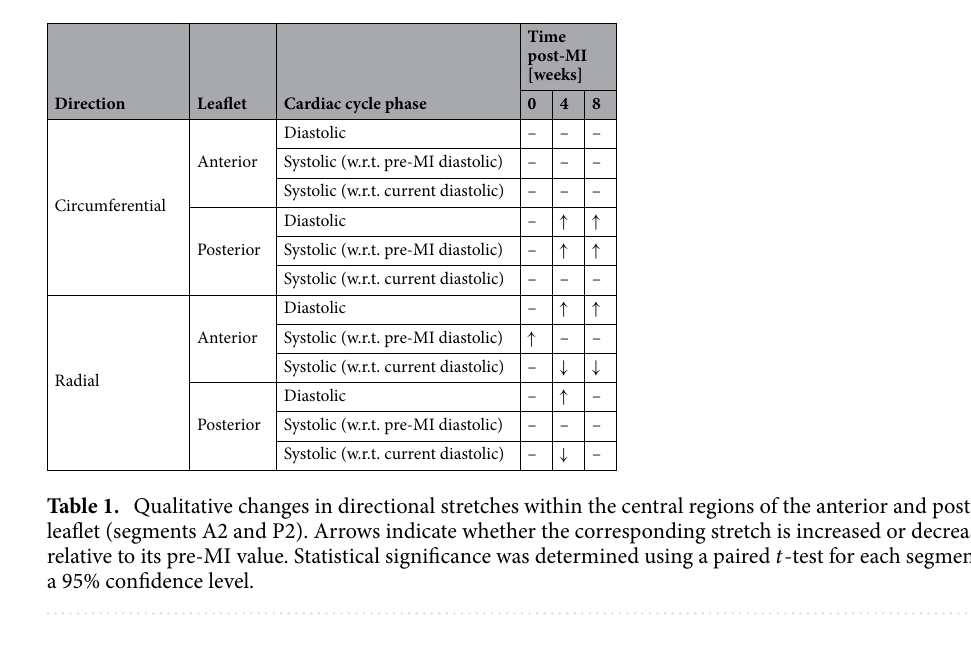
Figure 7. Systolic stretches in both the circumferential and radial directions, referenced to the current time point’s diastolic configuration. Lines and error bars at each time point denote the mean and standard error across n = 8 specimens. Asterisk symbols (*) denote statistically significant differences from the corresponding pre-MI value with 95% confidence ( p < 0.05 yielded by a paired t -test). While results in Figs. 4a and 6 demonstrate that the systolic configuration of the MV actually remains largely unchanged post-MI, the results above highlight that the radial deformation experienced by the leaflets over the current cardiac cycle is significantly decreased throughout several regions of the leaflet, due to the effects of tethering that stretch out the leaflets in diastole over time.